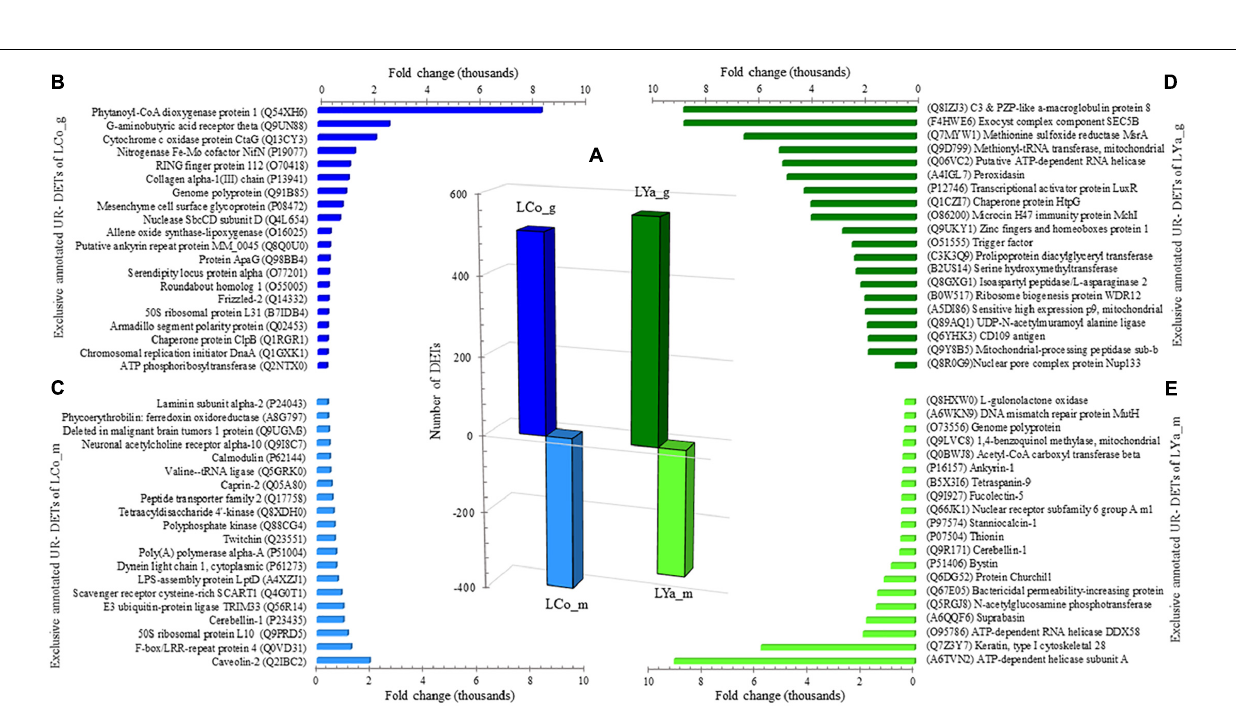
FIGURE 3 | Intra-location by tissue comparison. The number (bars) of differentially expressed transcripts (DETs) by location are in the central plot (A) ; the number of up-regulated (UR-) DET from mantle tissue by location is in negative values. Also are showed the top twenty exclusive annotated UR-DETs from gills (B) and mantle (C) tissues for samples from Cochamó (left) and Yaldad (right, D,E , respectively). LCo, local individuals from Cochamó and LYa, locals from Yaldad. _m, mantle samples and _g, gill